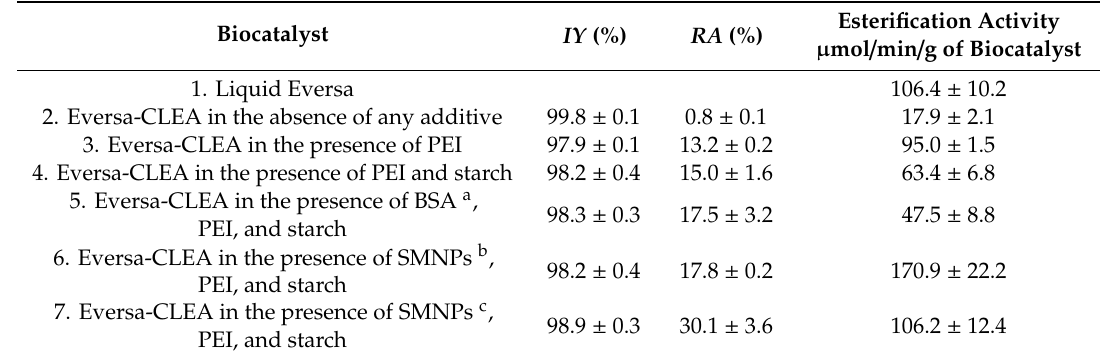
Table 1. Effect of polyethyleneimine (PEI), starch, and the additives bovine serum albumin (BSA) or silica magnetic nanoparticles (SMNPs) on the immobilization yields ( IYs ) and recovered activities ( RAs ) of Eversa-CLEAs, and specific esterification activities of the biocatalysts.